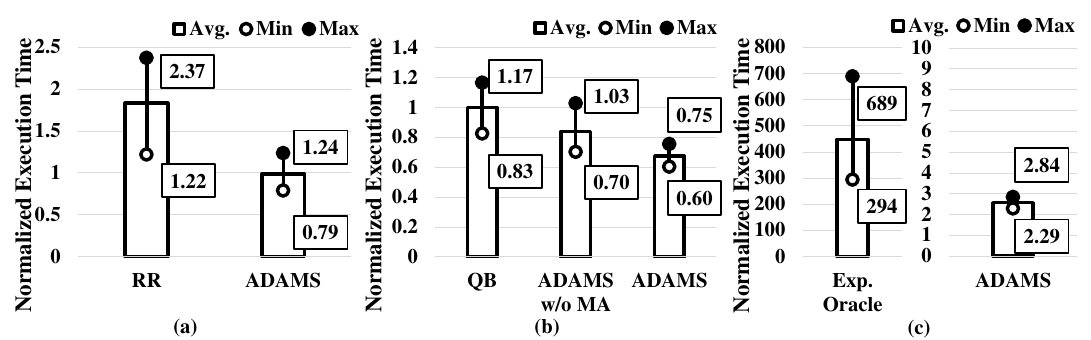
Figure 9. Performance comparisons. ( a ) Effectiveness of proposed allocation policy and ( b ) effectiveness of global memory consideration in the Non-Shared-Memory System. ( c ) Effectiveness of global memory consideration in the Shared-Memory